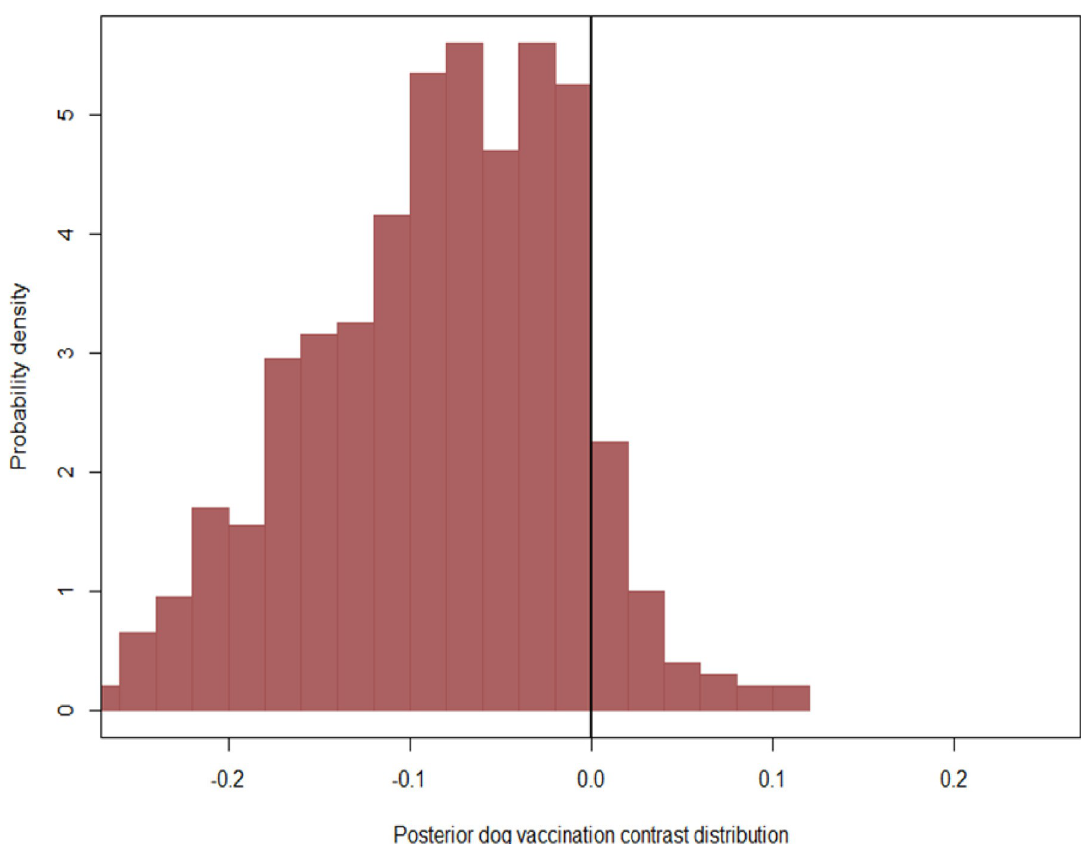
Fig 2. Posterior marginal contrast distribution demonstrating how the estimated posterior probability of deaths was predicted to change when comparing bites from unvaccinated dogs to bites from vaccinated dogs.